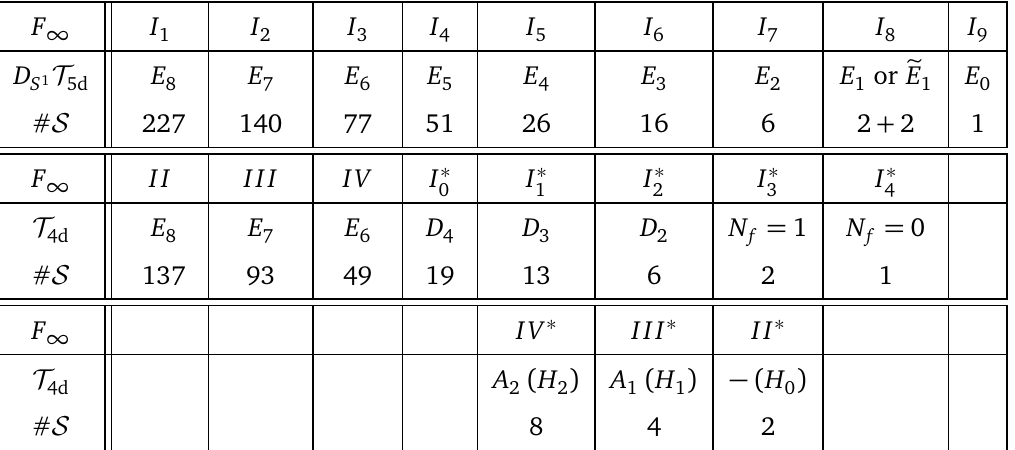
Table 1: Correspondence between the singular fiber at infinity and the 5d and 4d theories. The field theories are denoted by their flavour symmetry algebra, except = 1 and N = 0 flavours (denoted by N = 1 for the SU ( 2 ) gauge theory with N f f f = 0, respectively). Thus, D and N denotes the SU ( 2 ) theory with N flavours. f N f f The bottom line corresponds to the 3 AD theories H , which can be found on the N f − 1 > 0 gauge theory for N = 1,2,3. We also give the number of CB of the SU ( 2 ) , N f f distinct CB configurations, # S , in each